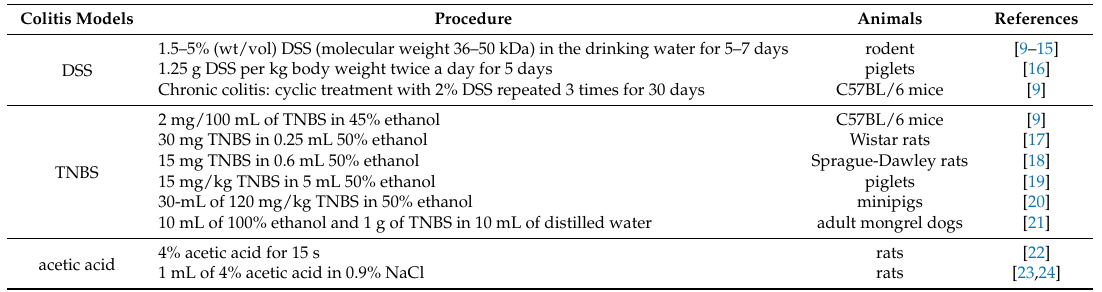
Table 1. Examples of chemical-induced inflammatory bowel disease (IBD) animal models. Colitis